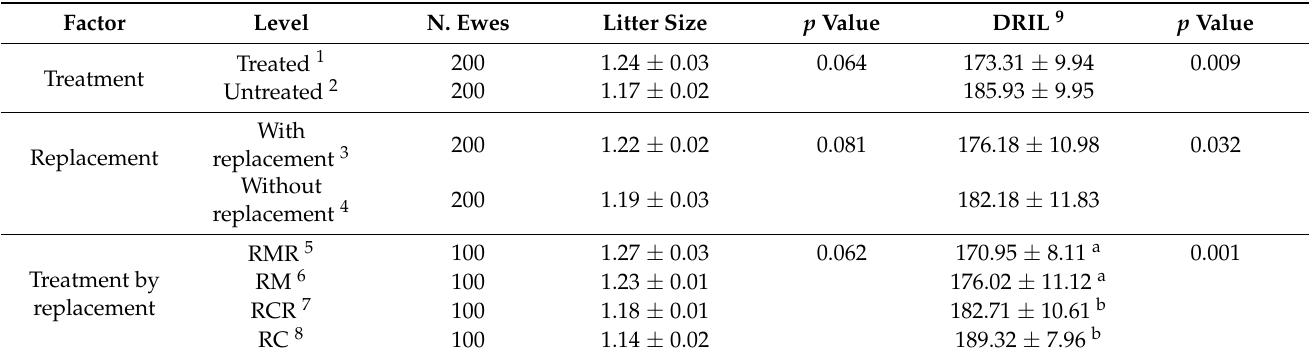
Table 3. Least square means ( ± SEM) for litter size and DRIL of the levels of treatment effect, replacement effect, and interaction between treatment and replacement effect with significance of contrasts between least square